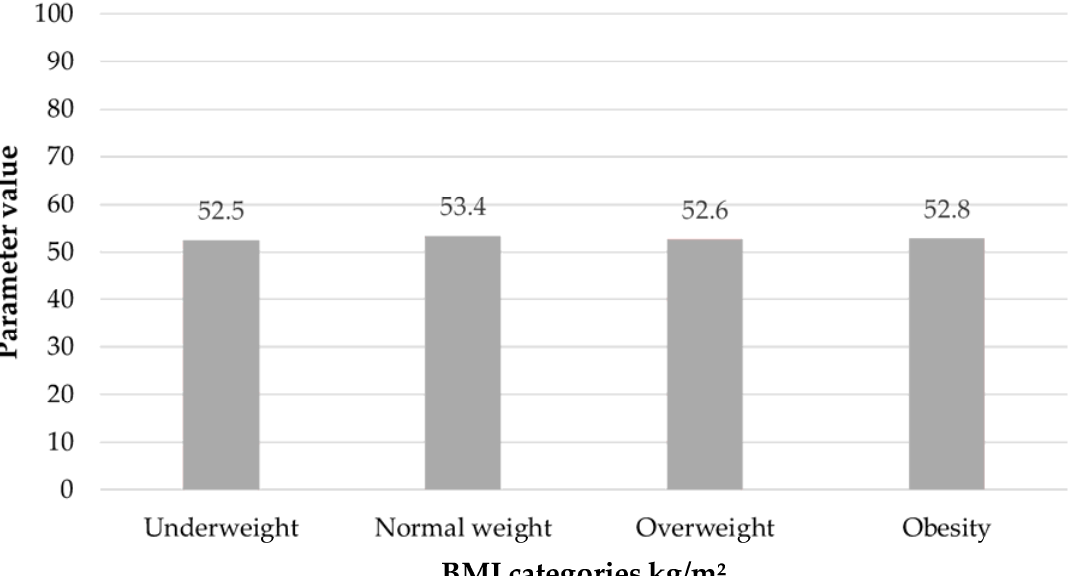
Figure 4. CECS- Total score depending on BMI ( p = NS).